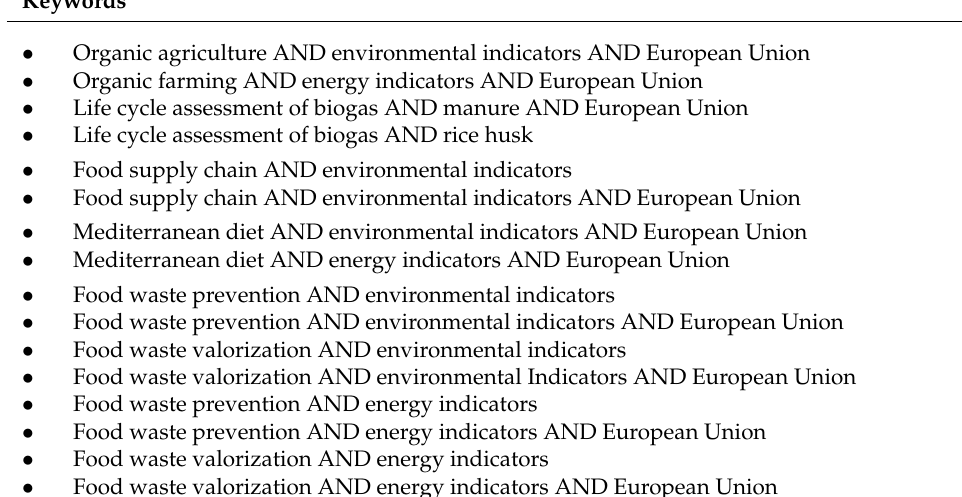
Table 1. Keywords used for searching the literature (investigated time period: 1 January